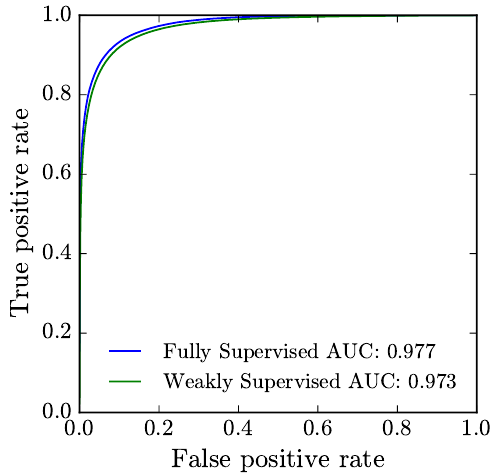
Figure 4 . Receiver operator characteristic (ROC) curve for the weakly supervised and fully super- vised networks. The performance is very similar for the two